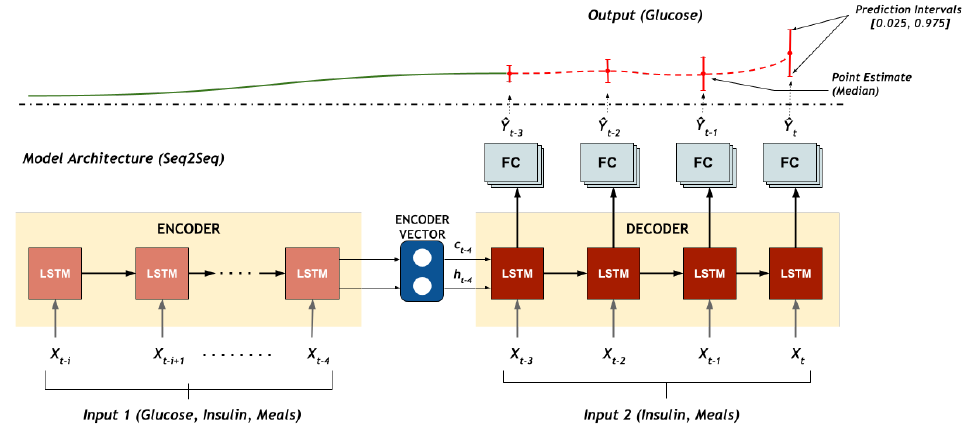
Figure 1. The multitask deep neural network architecture for predicting the 20 min glucose trajectory at multiple quantiles. The multitask seq2seq model predicts glucose trajectory with a 95% prediction interval (PI) with a lower bound (2.5%) and upper bound